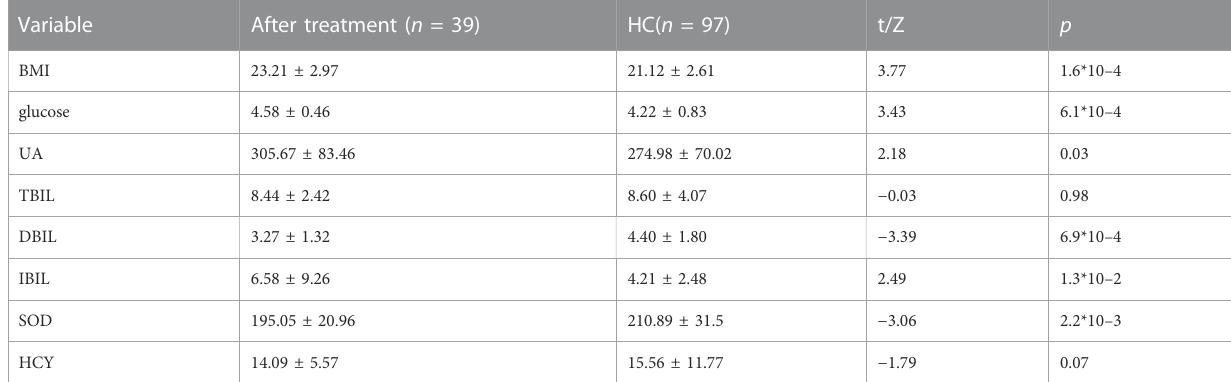
TABLE 3 Peripheral biochemical indicators at SCZ after treatment and HCs.